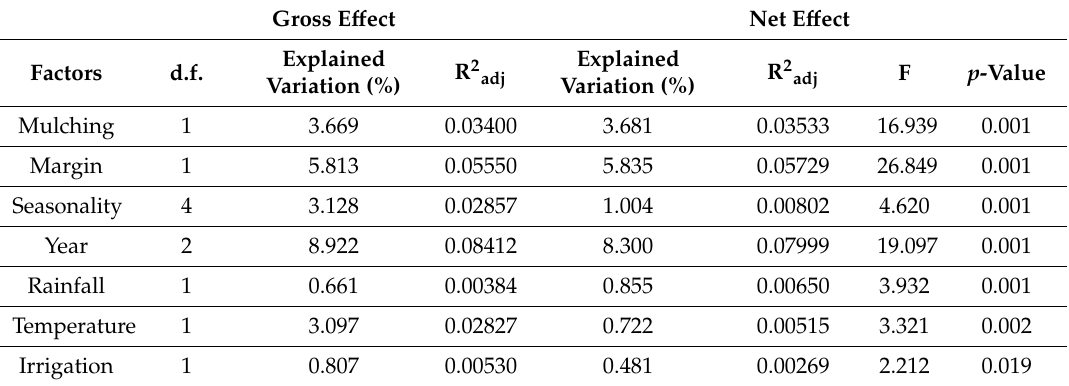
Table 1. Gross and net e ff ects of explanatory variables on weed composition in an open-field tomato experiment using redundancy analysis (RDA) with single explanatory variables (Gödöll˝o, Hungary,